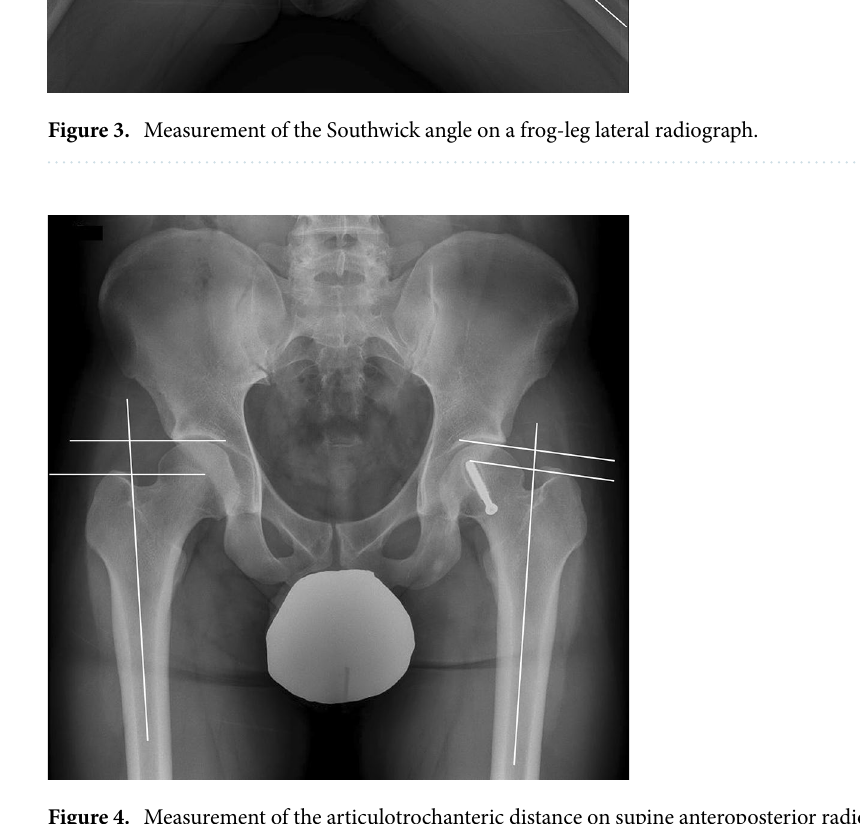
Figure 4. Measurement of the articulotrochanteric distance on supine anteroposterior radiograph of the hip. Articulotrochanteric distance difference was calculated as healthy side minus the involved